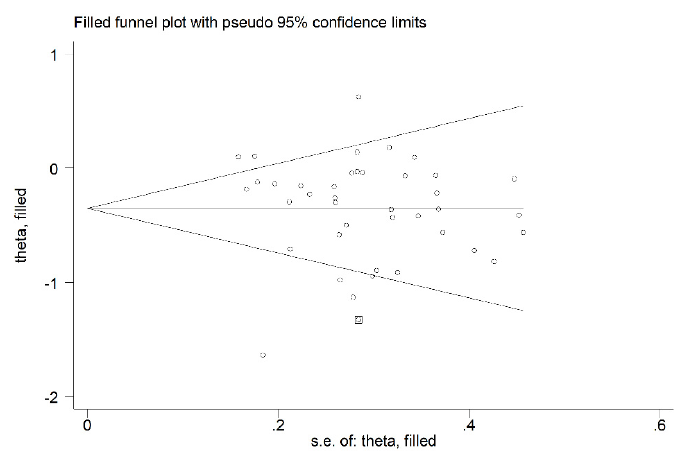
Figure 4. Funnel plot of P-Selectin concentrations before and after statin treatment after “trimming- and-filling”. Dummy studies and genuine studies are represented by enclosed circles and free circles, respectively.